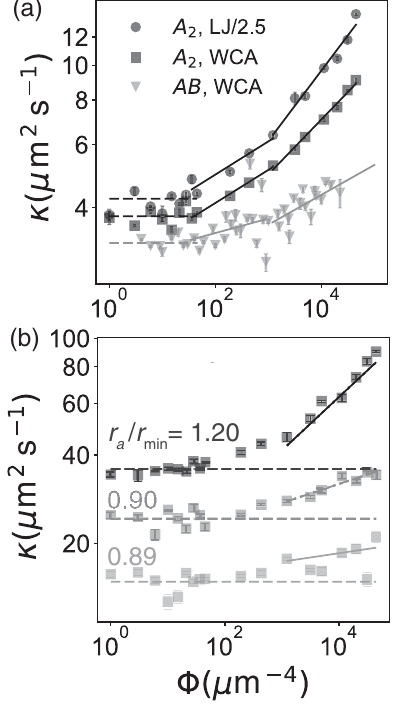
FIG. 3. Concentration-dependent diffusion-limited reaction rate: (a) The rates of association reaction κ depend on the mass action Φ . The functional form of κ ð Φ Þ is independent of the interaction potential but depends on the association reaction. The solid lines are guides for the eye, whereas the dashed lines show the value of κ 0 ¼ lim Φ → 0 κ ð Φ Þ . (b) κ ð Φ Þ depends on the reaction radius r . The lower the r , the more slowly κ ð Φ Þ increases with a a Φ . To compute these results, we use D ¼ 10 μ m 2 = s. The change in diffusion constant does not change the result qualitatively (see Fig. S3 in the Supplemental Material